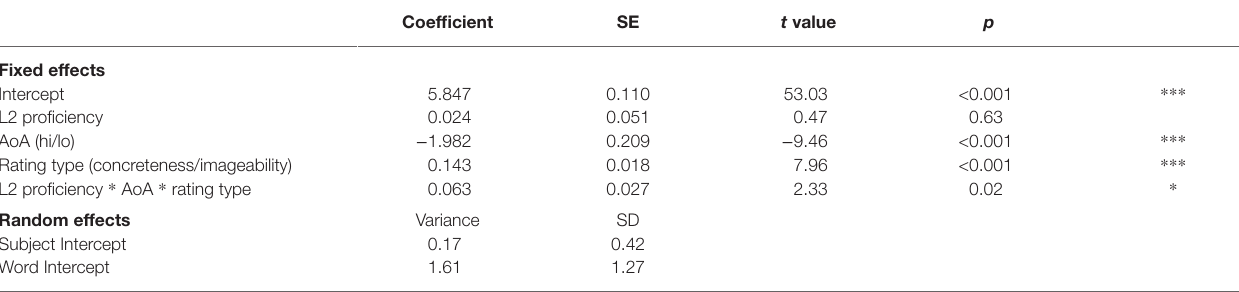
TABLE 6 | Linear-mixed effects regression model summary for AoA, imageability, and concreteness.